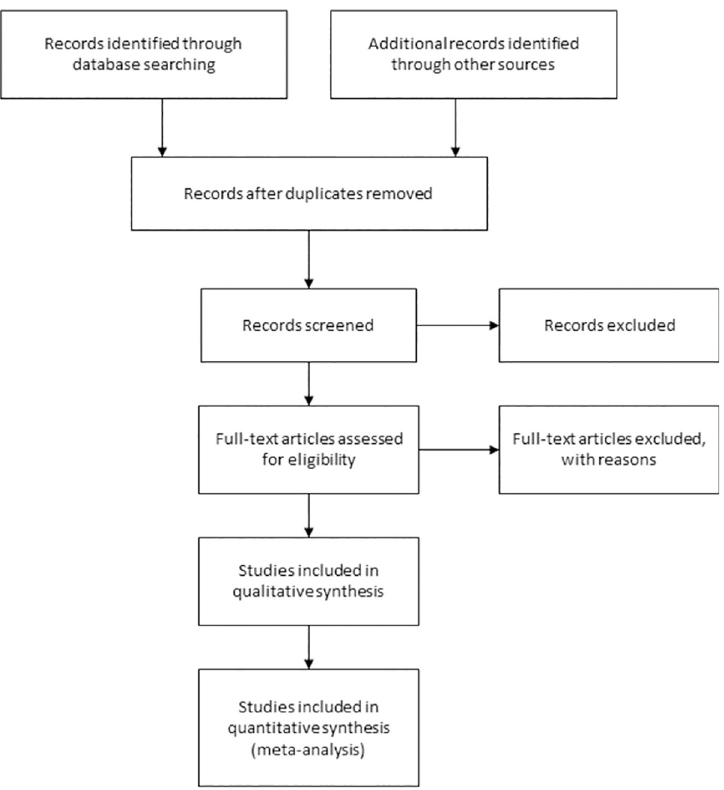
Fig 1. Flow diagram of the planned study selection process adapted from the Preferred Reporting Items for Systematic Reviews and Meta-Analysis (PRISMA) statement.